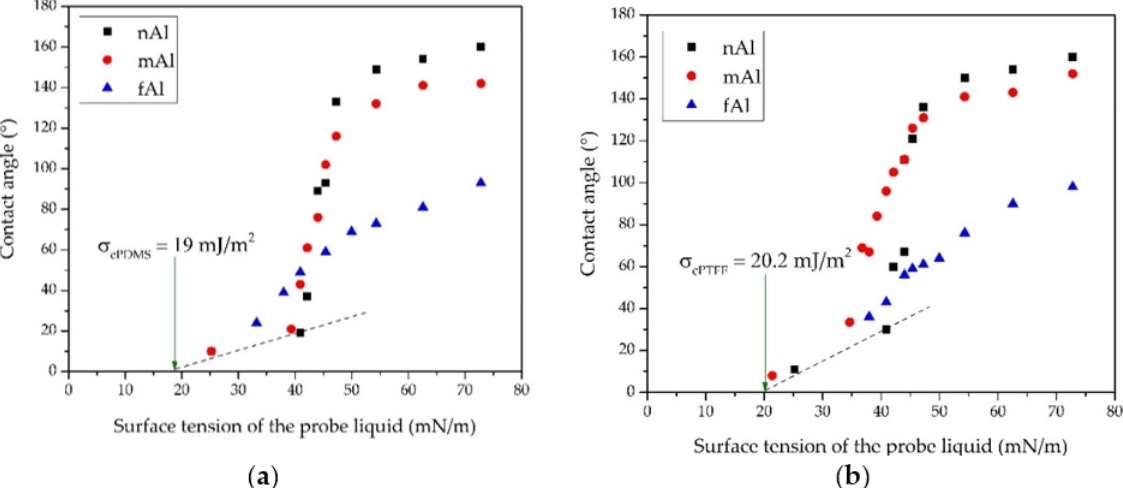
Figure 4. Contact angles of a probe liquid with variable surface tension on aluminum surfaces chemically treated with ( a ) OCTEO; ( b ) POTS. (black dot line is tangent to